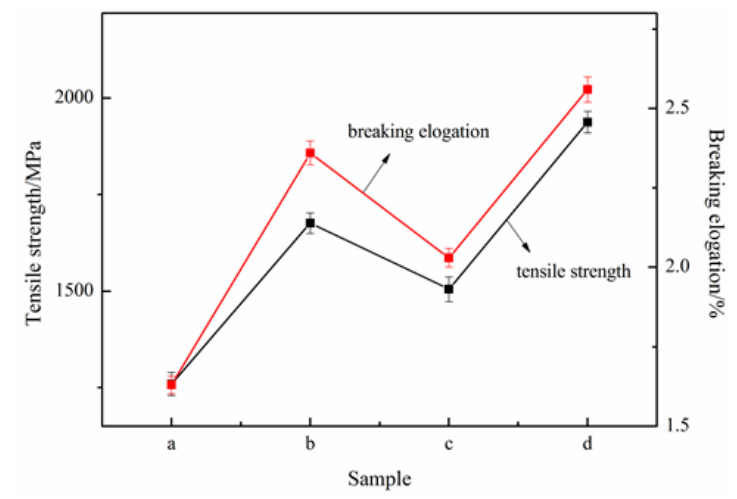
Figure 8. The tensile properties comparison of carbon fiber (CF) and epoxy composites ( a ) epoxy resin (EP)/CF; ( b ) GnPs-OH/EP/CF; ( c ) MWCNTs-OH/EP/CF; ( d ) hybrid materials/EP/CF.